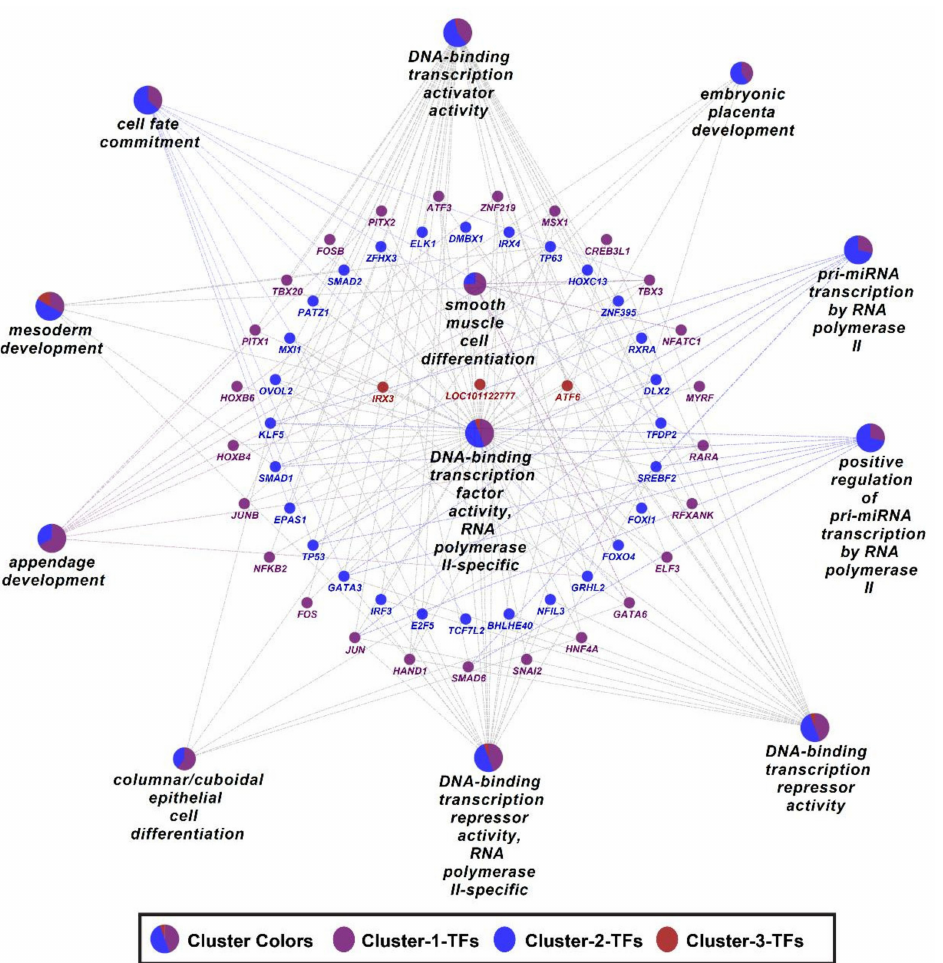
Figure 11. GO enrichment analysis for BPs of 3 clusters of differentially expressed transcription factors. Different pie colors in BPs shapes represent the proportion of TFs from different clusters. A complete list of BPs significantly enriched by differentially expressed TFs is provided in Table